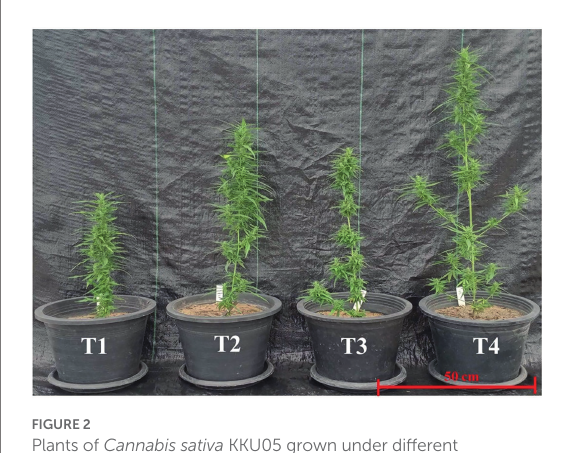
FIGURE 2 Plants of Cannabis sativa KKU05 grown under different conditions: T1, control without AMF inoculum; T2, Non- mycorrhizal plants with synthetic NPK fertilizer; T3, Plants inoculated with Rhizophagus. prolifer PC2–2 and T4, Plants inoculated with R. aggregatus BM-3 g3 (Photos were taken 60 days after the start of treatment).